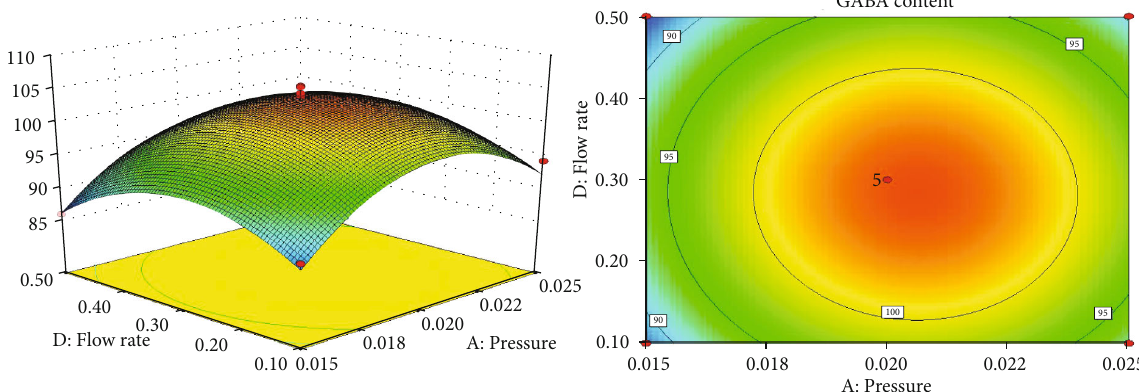
Figure 18: Response surface and contour diagram of pressure and fl ow rate in fl uence on GABA content.